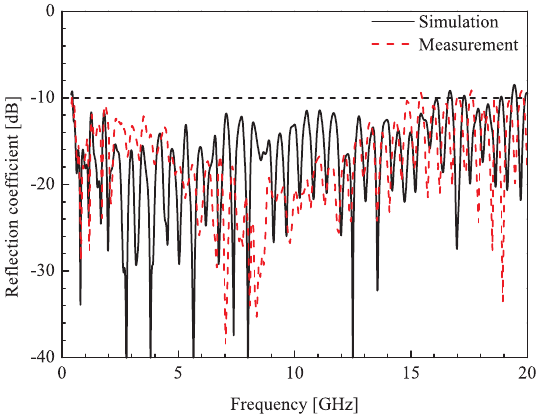
Figure 8. Simulated and measured reflection coefficients of the proposed antenna.